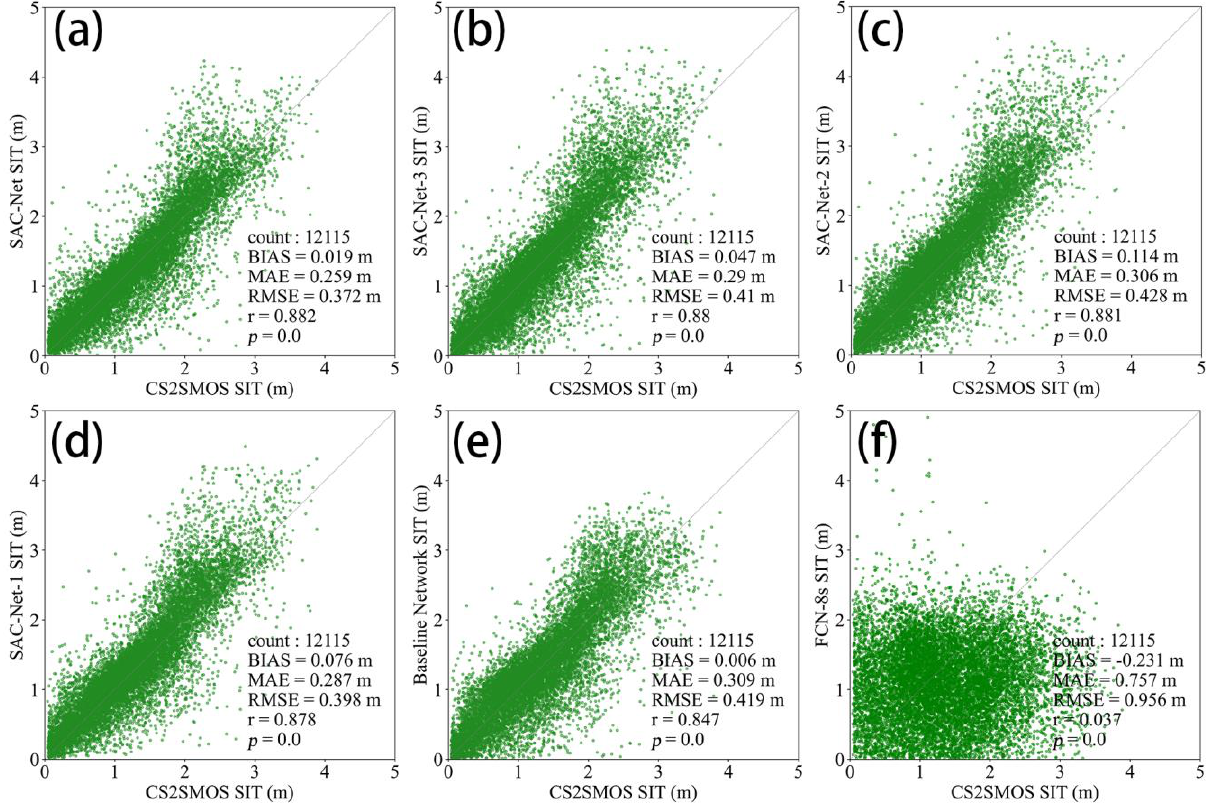
Figure 4. Statistical accuracies of the proposed SIT estimation model using the test data. ( a – d ) Scatter plots of the SIT estimated by the SAC-Net with four, three, two, and one attention layers vs. CS2SMOS SIT; ( e ) scatter plot of baseline network estimated SIT vs. CS2SMOS SIT; ( f ) scatter plot of FCN-8s estimated SIT vs. CS2SMOS SIT.